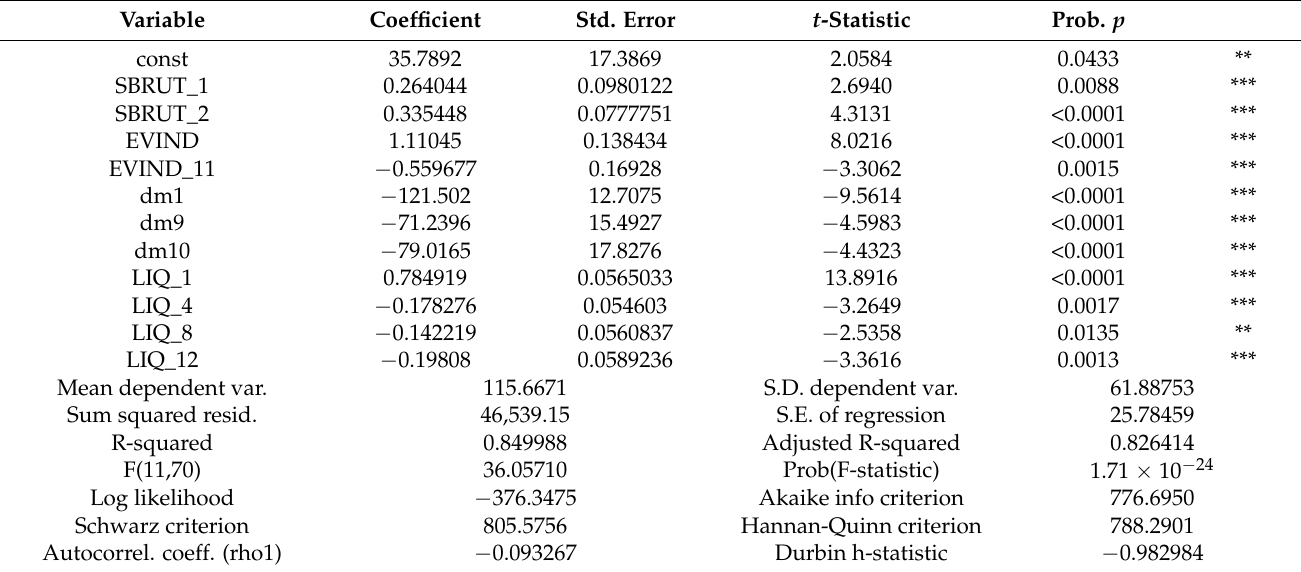
Table 1. Dependent variable: LIQ t ; observations used 1997:03–2003:12 (N =